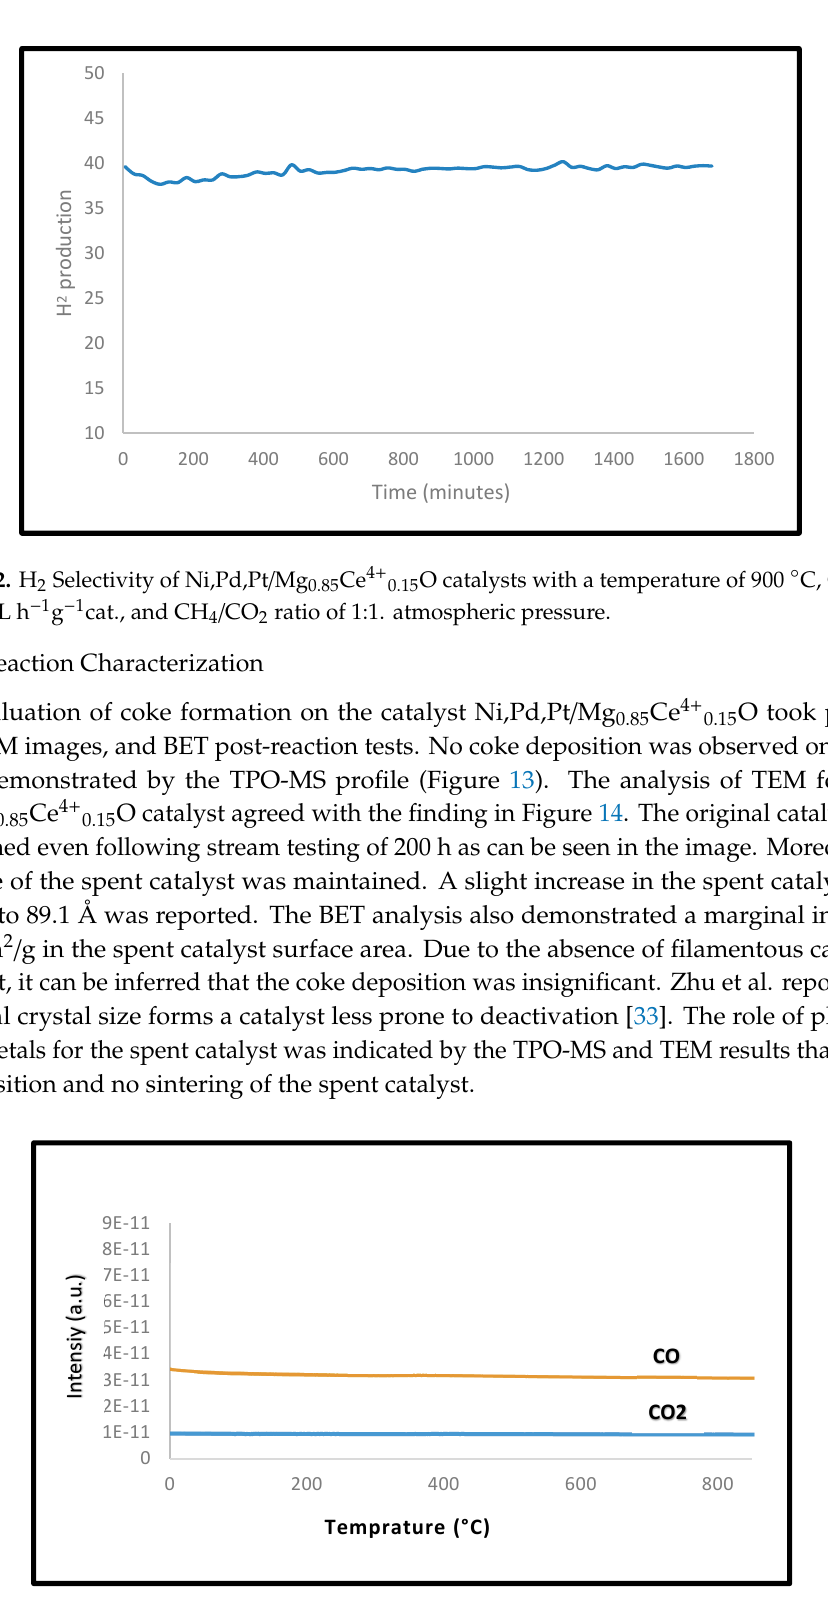
Figure 13. Temperature programmed oxidation TPO curves of spent Ni,Pd,Pt / Mg 0.85 Ce 4 + 0.15 O catalyst after reaction at T = 900 °C with ratio of 1:1 CH 4 /CO 2 . and GHSV = 15,000 mL h − 1 g − 1 cat.